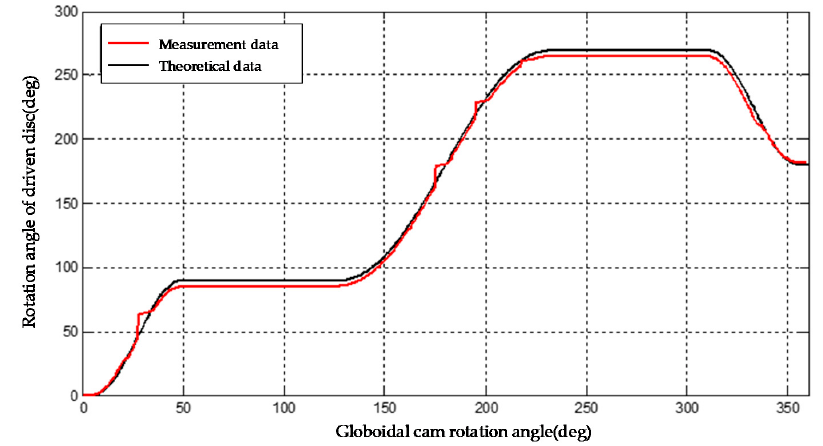
Figure 8. Transmission curve of CAM I.